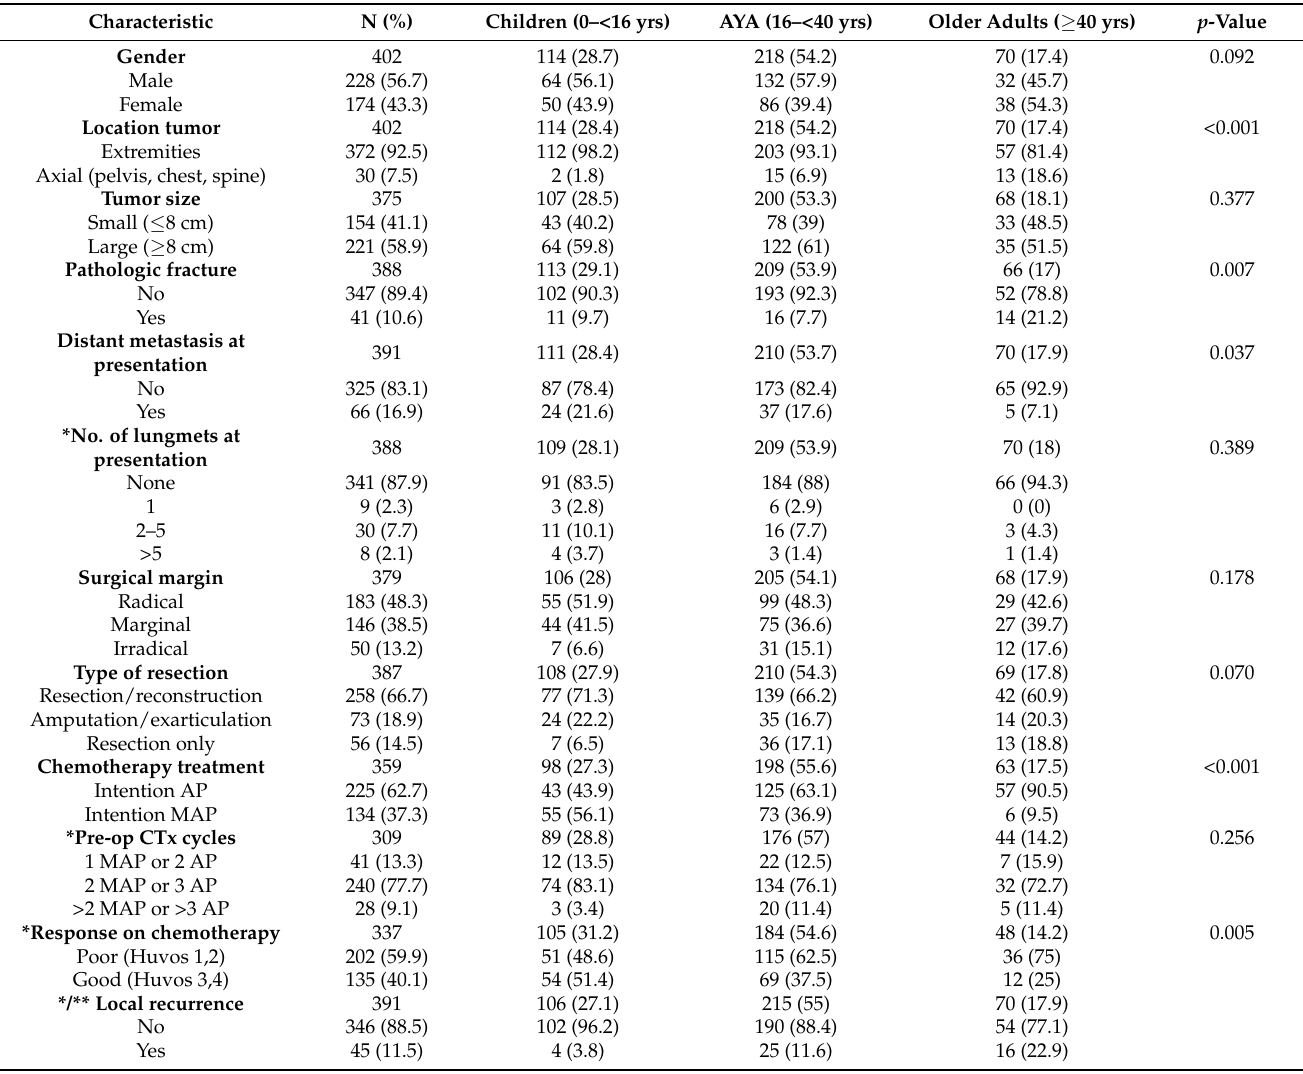
Table 1. Characteristics of the overall cohort diagnosed with skeletal high-grade osteosarcoma.